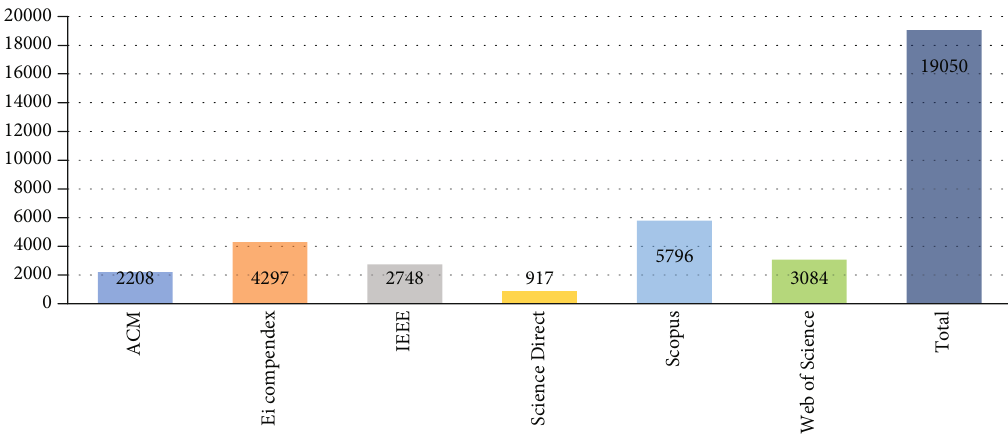
Figure 3: Number of studies returned by the search